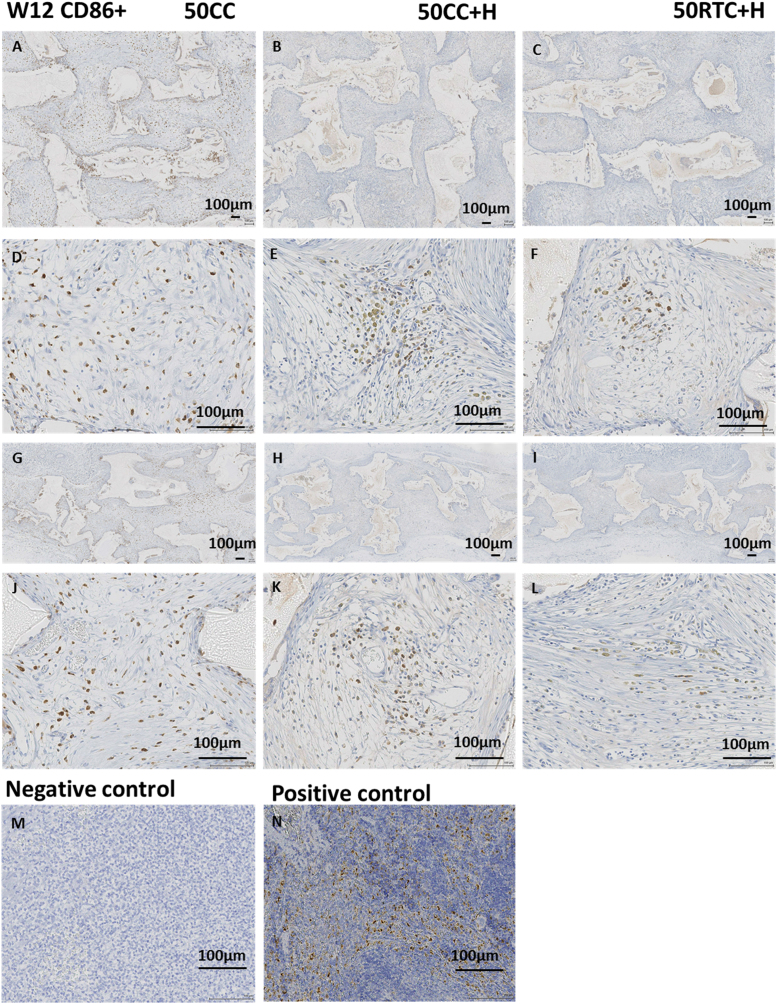
Immunohistochemistry of the host macrophage response towards scaffolds in vivo at week 12. Tissue integration of middle-in-plane (A-F) and cross-sectional view (G-L) of the scaffolds by CD86 (M1 macrophage marker) staining at (A-C, G-I) ×4 and (D-F, J-L) ×20 magnifications. (M) Negative control (rat appendix); (N) positive control (rat liver). Scale bar: 100 μm.